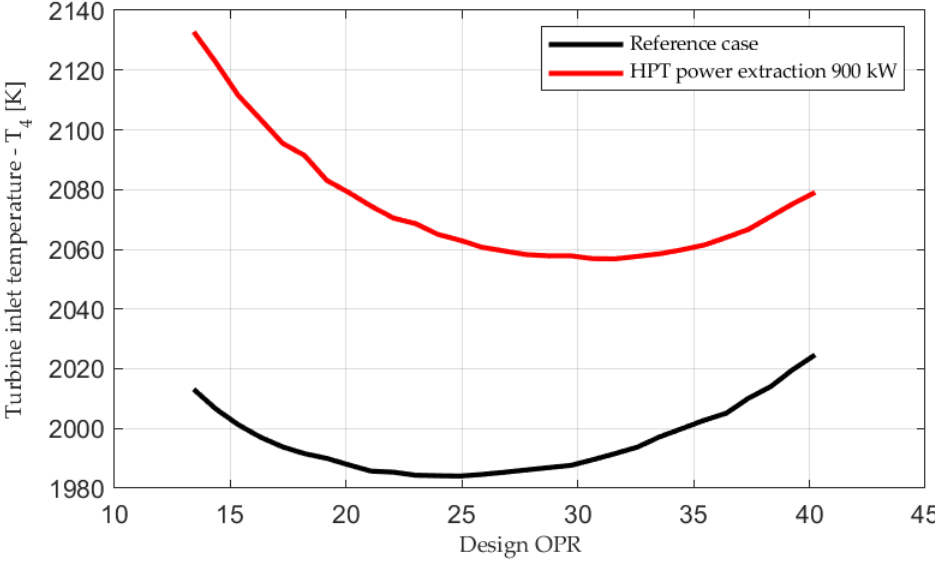
Figure 15. Point 2 of the mission. T 4 plotted versus design point OPR.